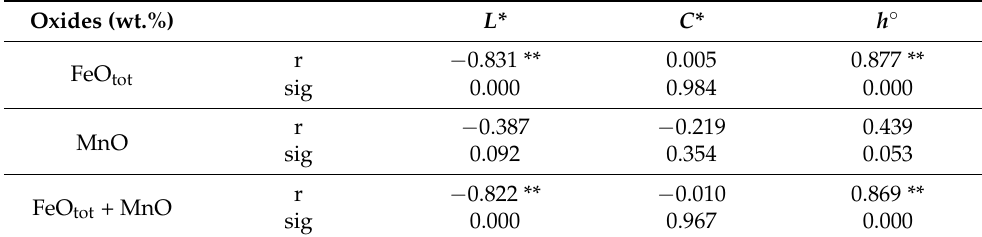
Table 3. Results of bivariate correlation analysis.